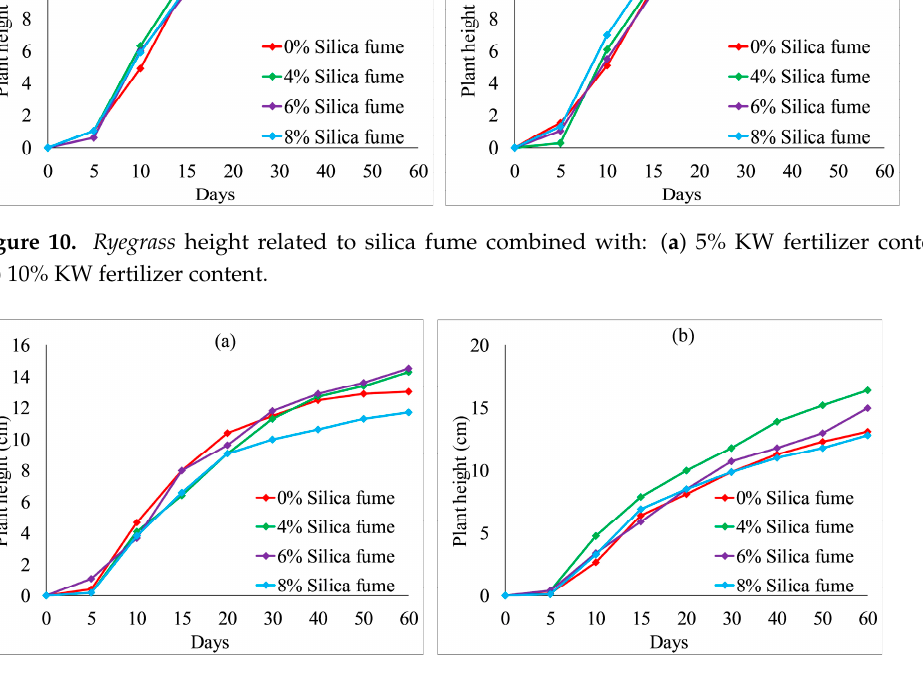
Figure 11. Festuca elata height relative to silica fume content combined with: ( a ) 5% KW fertilizer content; ( b ) 10% KW fertilizer content.